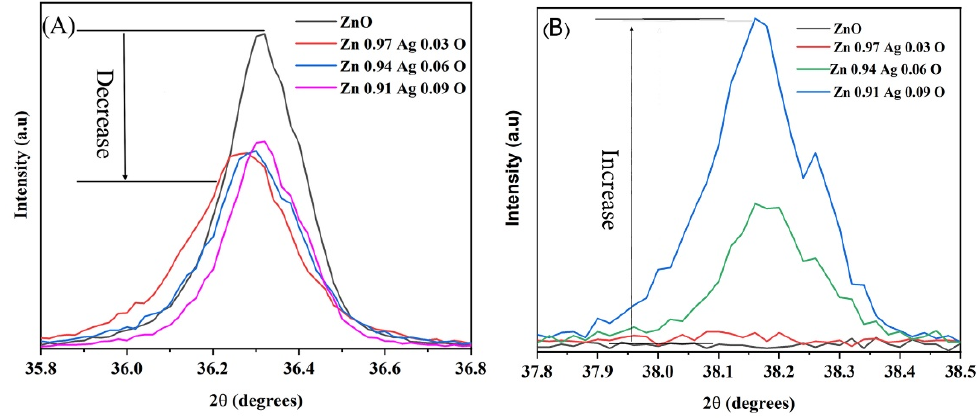
Figure 4. The XRD peak related to ( A ) the ZnO hexagonal and ( B ) Ag cubic